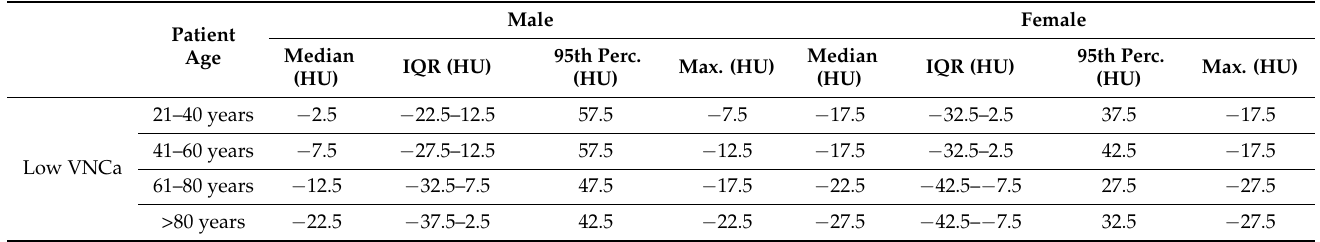
Figure 3. Summary statistics and patient characteristics. Histogram of patient age ( A ). Mean age of included patients was 61.0 ± 15.9 years. Dashed lines represent the borders of age subgroups for further analysis. Pie chart of patient sex ( B ). Patient sex was balanced in our dataset, including 88 females vs. 80 males. Pie chart of automated segmentation results ( C ). We achieved segmentation of 97.6% ( n = 8298) of all included thoracolumbar vertebrae in our sample ( n = 8500). Density chart of attenuation histogram overlap ( D ). Intraindividual consistency of our method was assessed by the overlap of attenuation histograms in consecutive exams. Median overlap was 92.9% [87.8–95.6]. 92.9% of follow-up examinations yielded at least a “good” and 65.3% an “excellent” intraindividual consistency (overlap > 80.0% and >90%, respectively). Table 1. Quantitative features of physiological bone marrow attenuation in virtual non-calcium (VNCa)